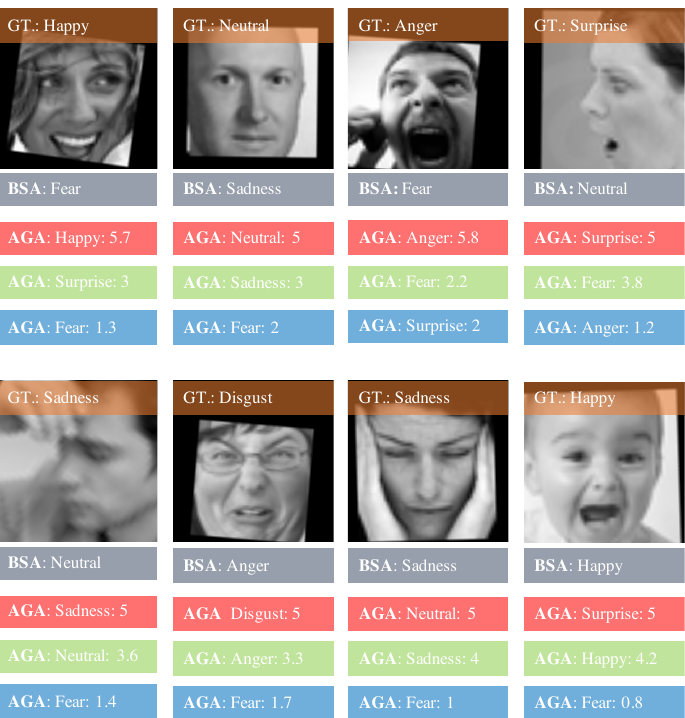
Figure 4. Visualizations of pseudo-labels from baseline method #3 and our AGA module. BSA represents baseline method #3.